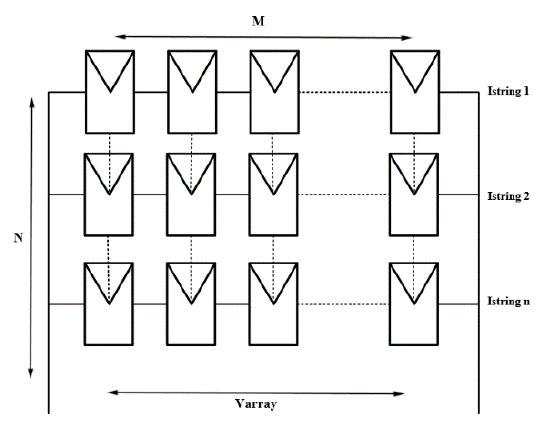
Figure 8. A series-parallel (SP) PV array involving N × M (number of parallel-connected strings × number of series-connected PV modules).